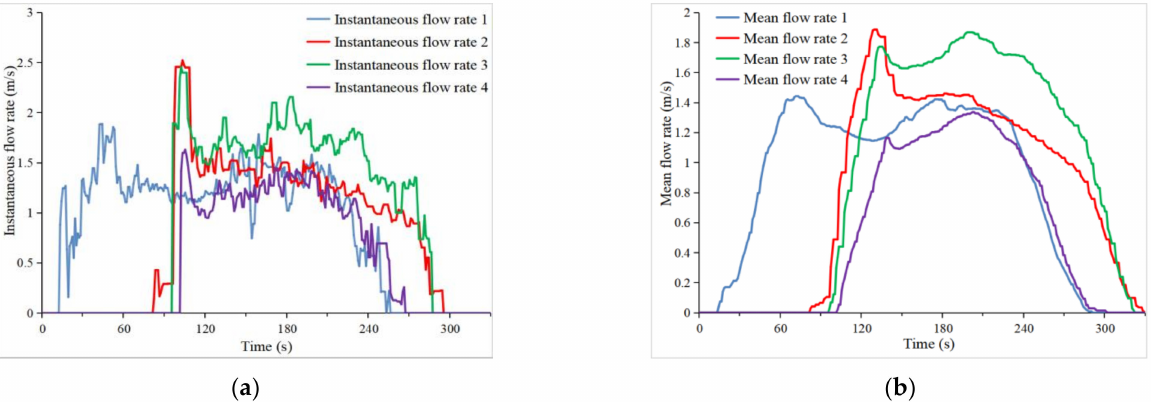
Figure 7. Flood topping dam breach full-field flow velocity change curve with time. ( a ) Instantaneous flow rate. ( b ) Mean flow